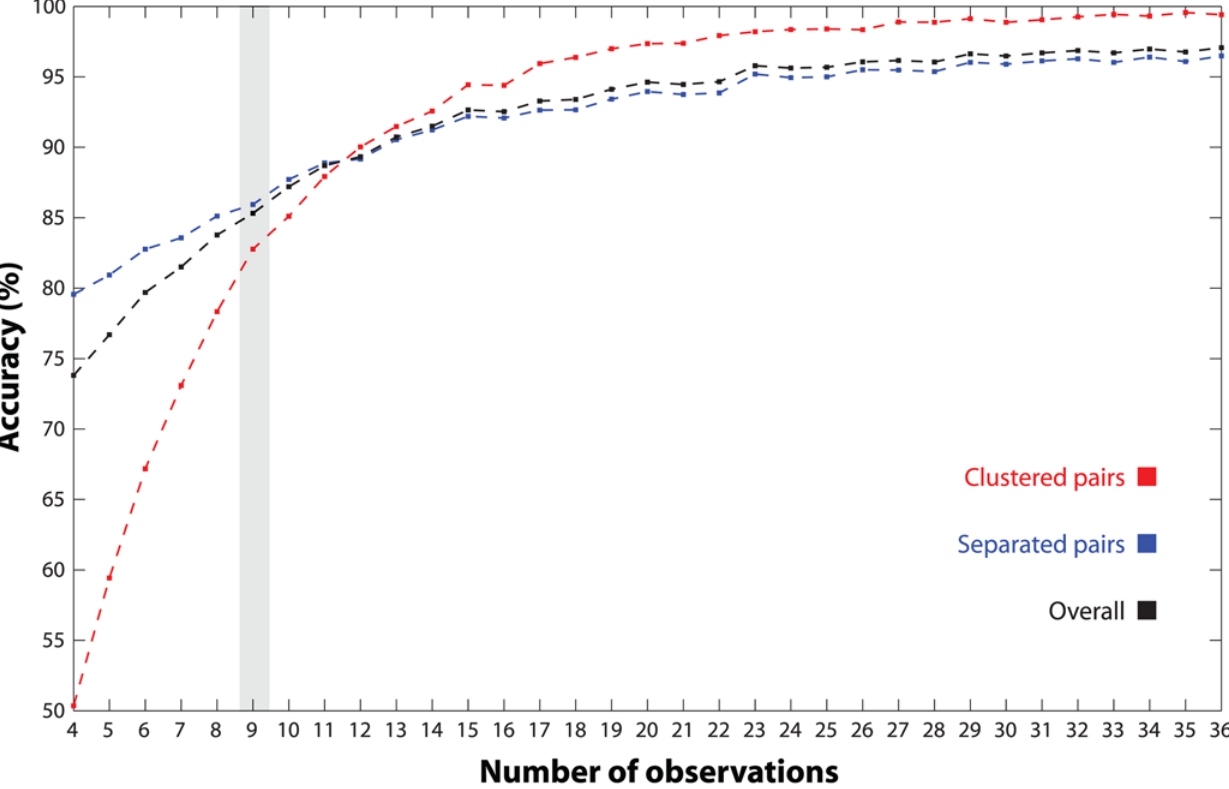
Figure 4. MMC analysis of simulated data. Three measures of accuracy are reported for MMC as the number of observations ranges from 4 to 36 in the simulation study. Shown in red for each case is the percentage of simulations in which pairs of variables are correctly clustered. Shown in blue is the percentage of pairs correctly separated; the overall percentage correct is in black. Each point on the plot represents the results across 1,000 datasets. The scenario considered in Table 1 (MMC default) is highlighted in